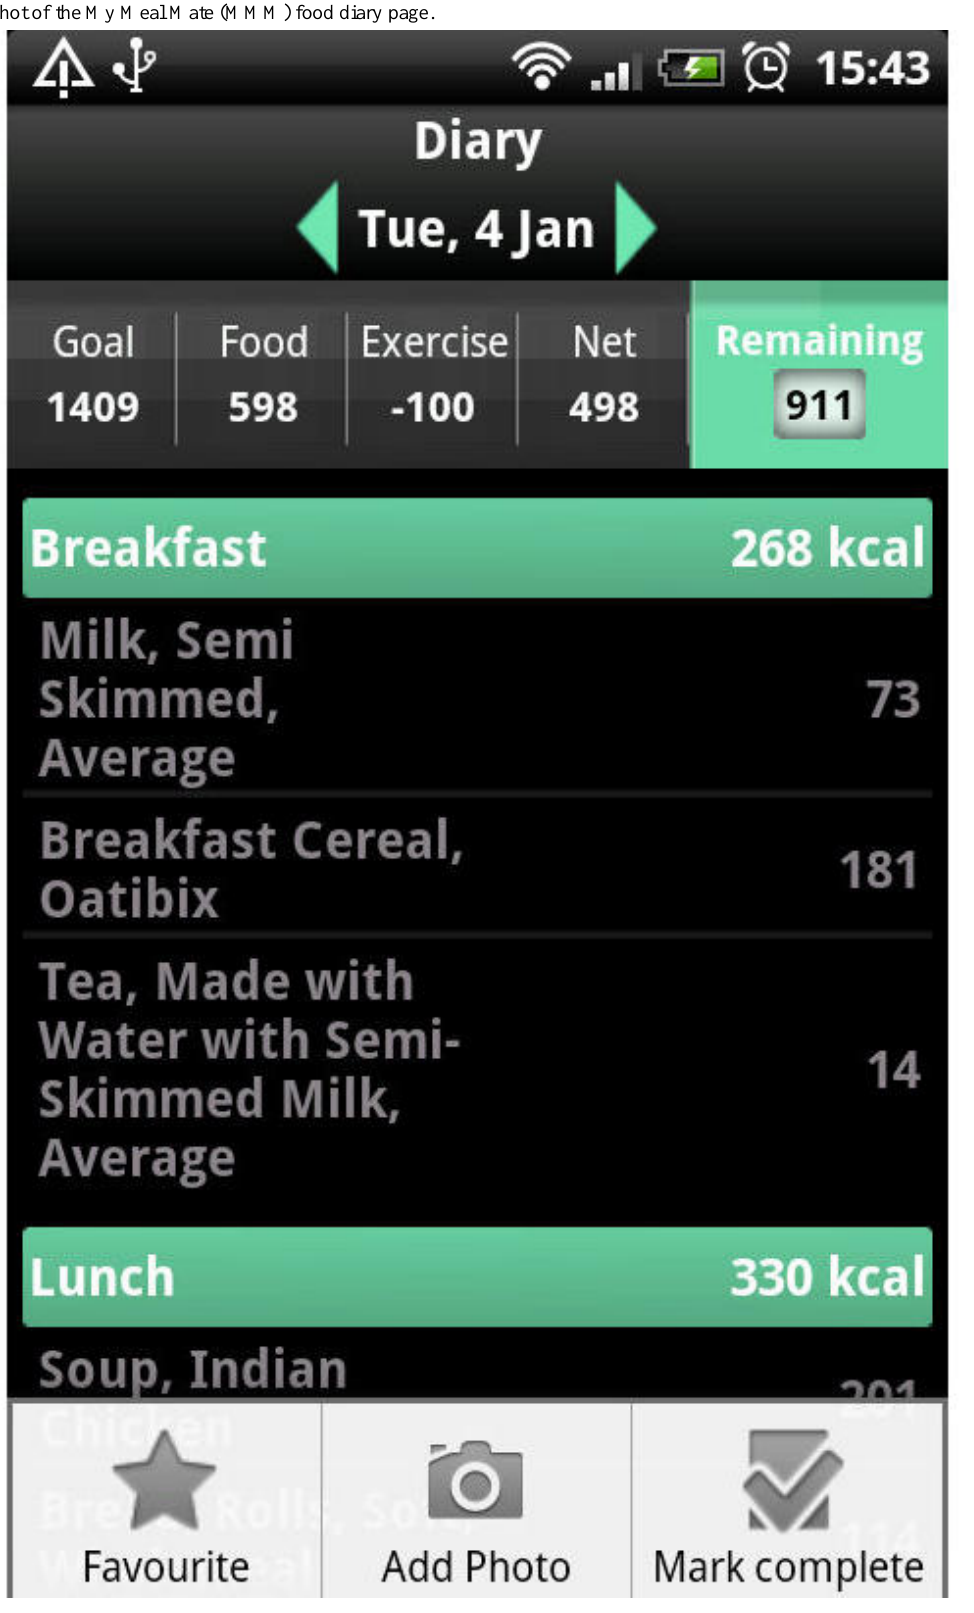
Figure 2. Screenshot of the My Meal Mate (MMM) food diary